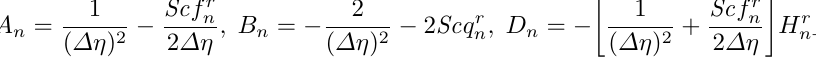
1 2 x for K = 0, Sc = 0 . 22 (Newtonian Present result